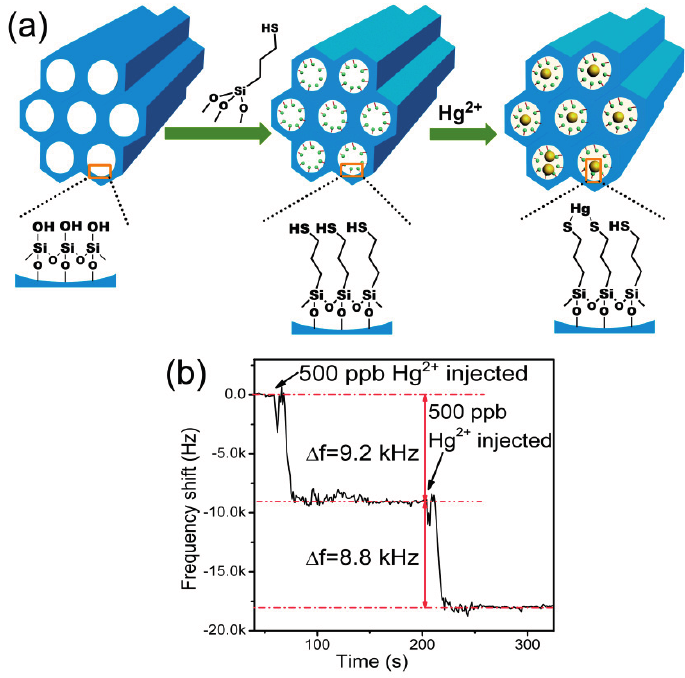
Figure 14. ( a ) Inner channel modification and Hg 2+ sensing mechanism of functionalized mesoporous silica; ( b ) Real-time detecting data of the sensing-material loaded cantilever for 500 ppb and 1000 ppb aqueous solutions. The Hg 2+ ion is prepared by injecting Hg(NO 3 ) 2 into aqueous solution. Reprinted with permission from